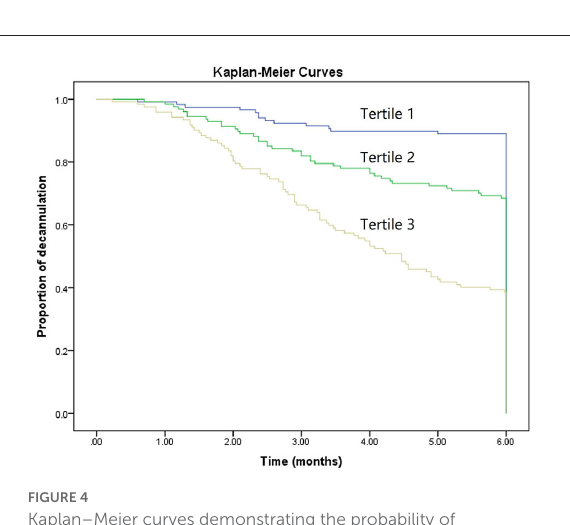
FIGURE3 Calibration curves for nomogram. Red dotted line represents the entire cohort ( n = 367), while blue solid line is the result after bias correction by bootstrapping (1000 repetitions), indicating nomogram performance.